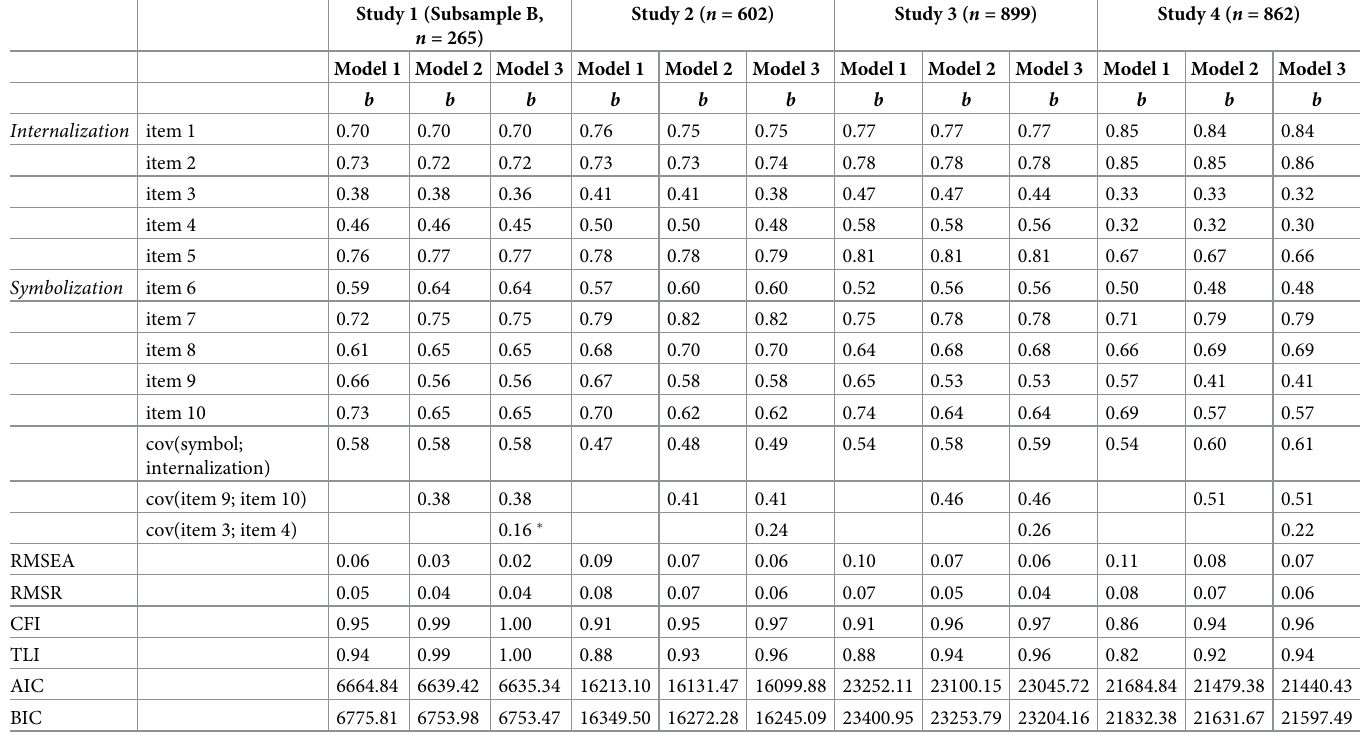
Table 3. Factor loadings and model fit indices of Confirmatory Factor Analysis (CFA) of SMIS items in Studies 1, 2, 3 and 4. Study 1 (Subsample